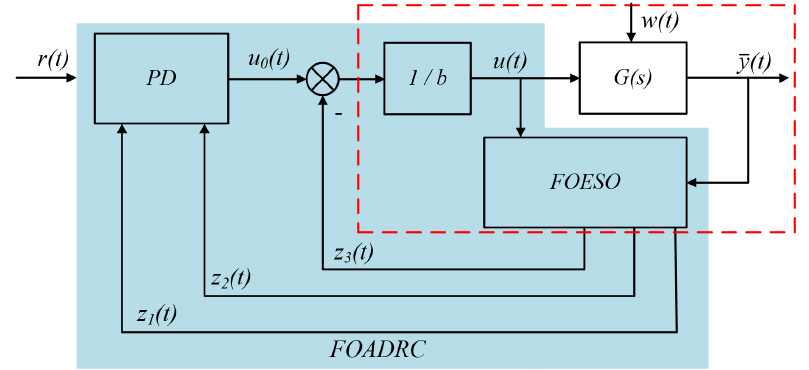
Figure 5. Block diagram of FOADRC